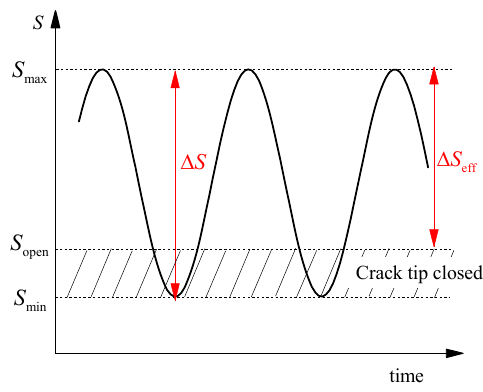
Figure 5. Plasticity-induced crack closure (where S max and S min are the maximum and minimum stress, S open is the minimum tension stress corresponding to crack opening).